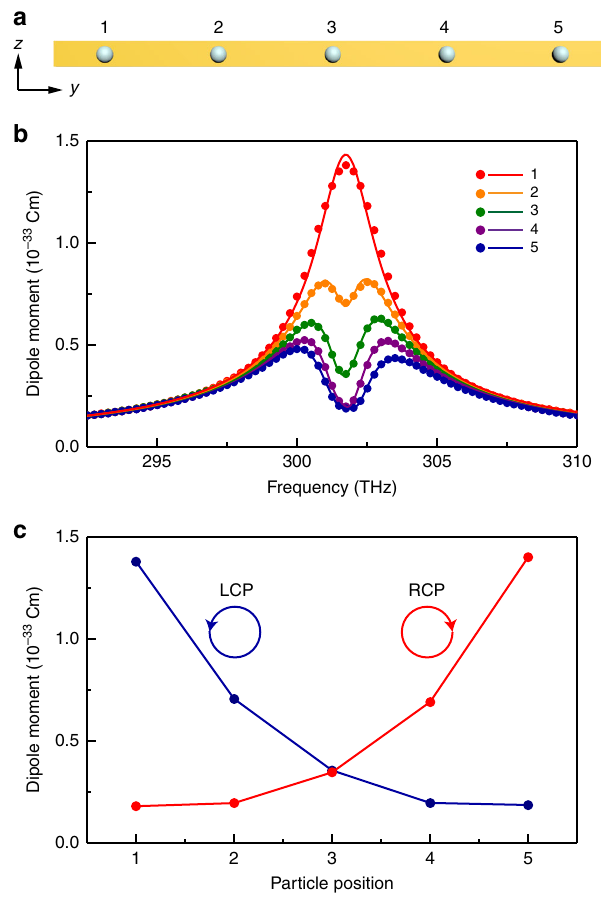
Fig. 3 Higher-order exceptional point in the model system. a N = 5 spheres placed on the waveguide with equal spacing of d = λ plas (top view). b Electric dipole moments of the fi ve spheres as a function of frequency under left-handed circular polarisation (LCP) excitation. The symbols denote the simulation results and the solid lines denote the results of coupled mode theory. c Resonant electric dipole moments of the fi ve spheres as a function of position under LCP and right-handed circular polarisation (RCP)